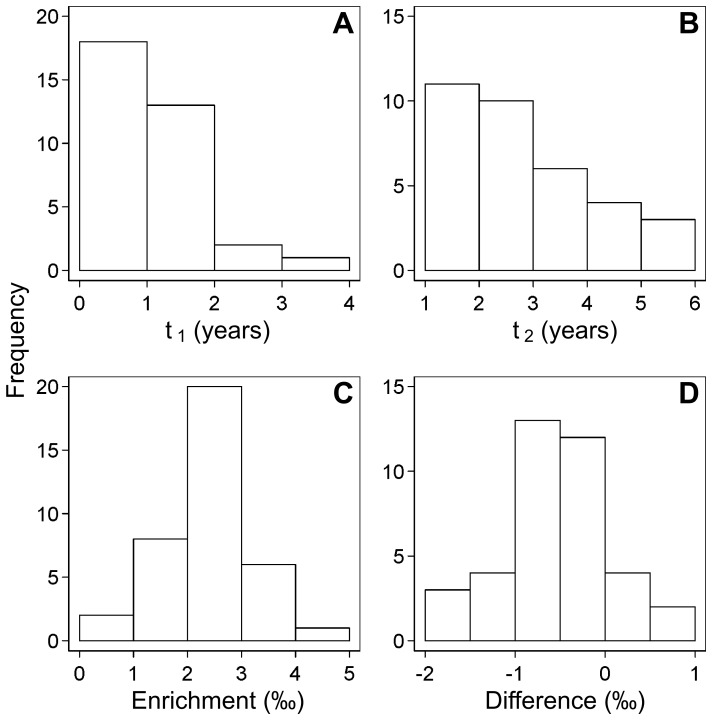
Histograms for the MDE distributions of the four weaning parameters for the archaeological populations.See Figure 3 for the meanings of the labels.